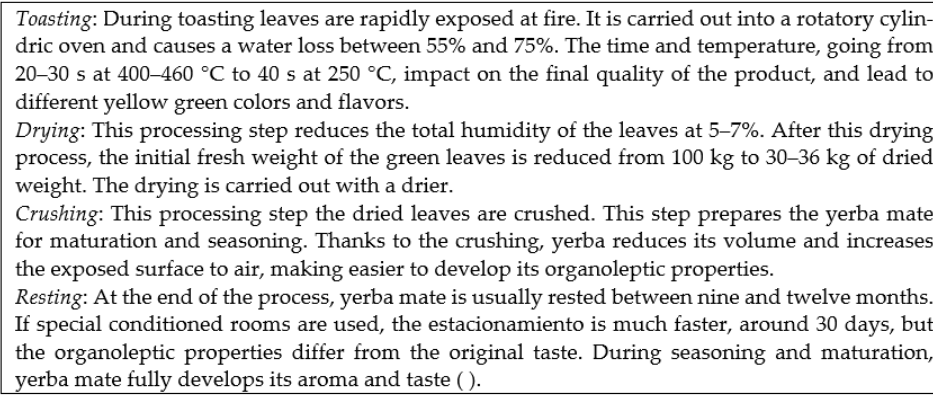
Figure 2. Yerba mate processing steps.